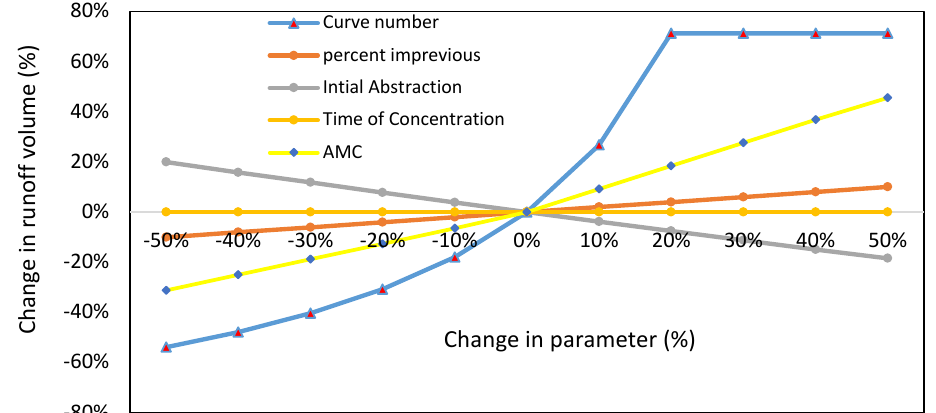
Figure 9. Sensitivity analysis results of HEC-HMS